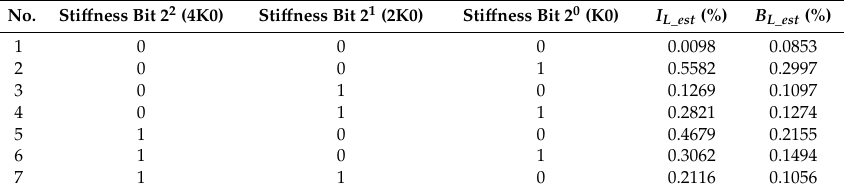
Table 3. Relative errors for the estimated parameters under the e ff ect of active and inactive clutches in the case of the second test.